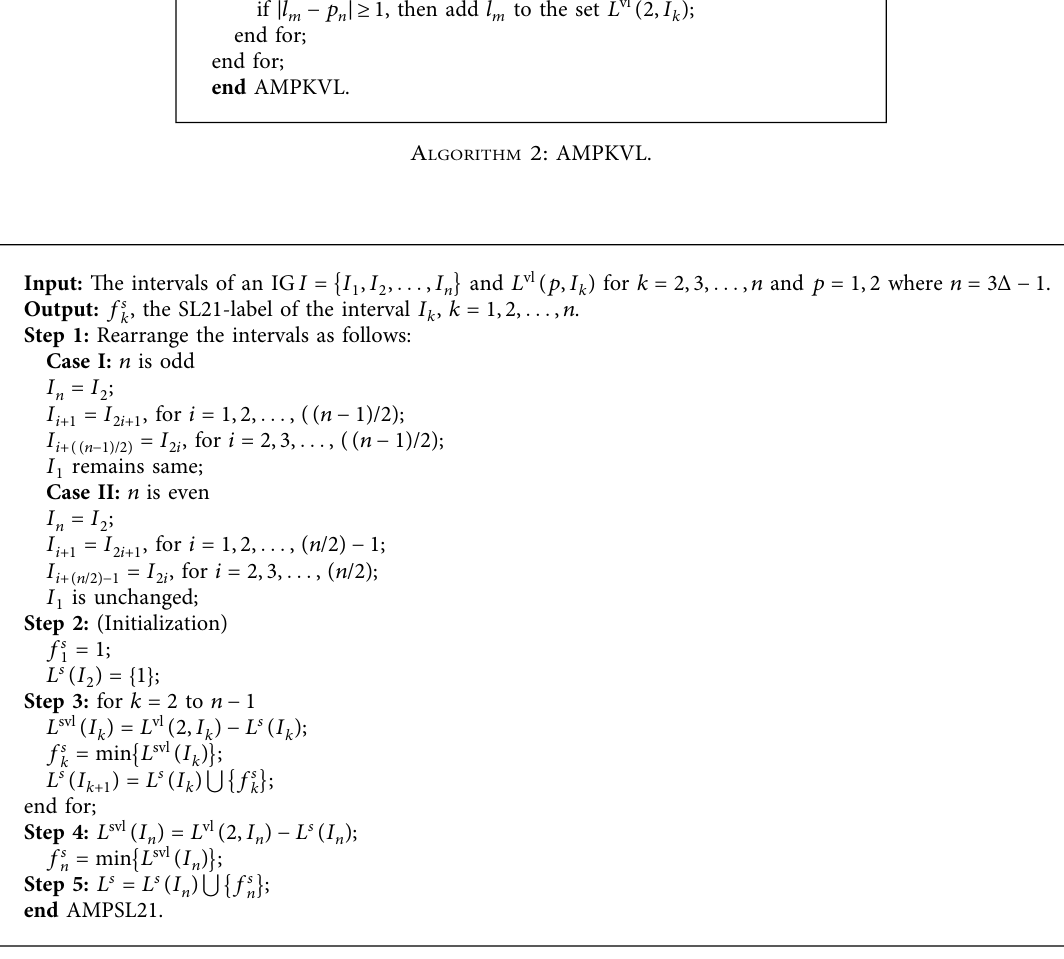
4.1.1. Illustration of Algorithm AMPSL 21 . We take an IG having 14 nodes (see Figure 9) and label that graph by Algorithm 3. The graph after completion of